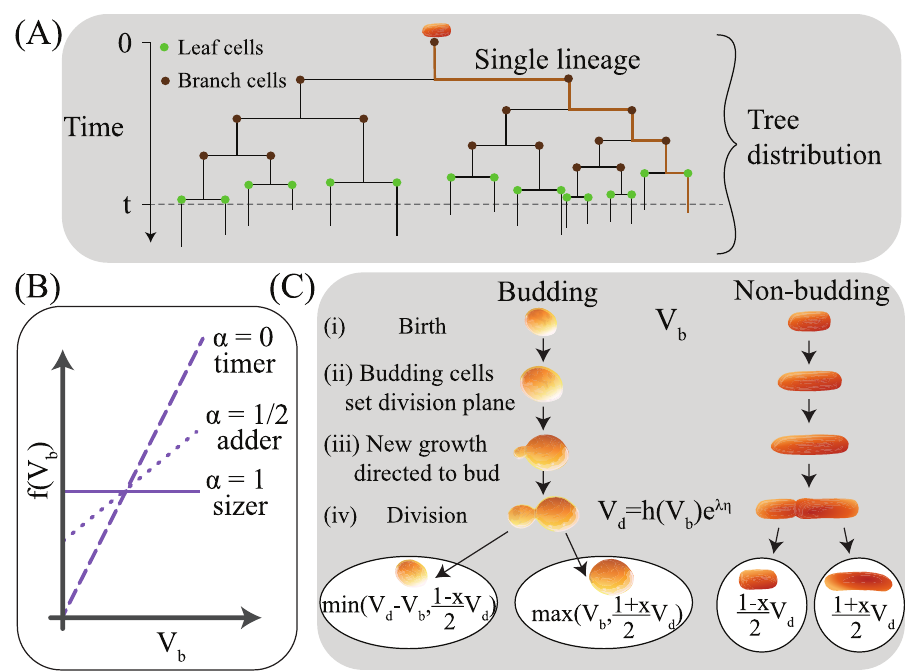
Fig 1. (A) Illustration of the tree distribution for a growing population of cells, terminated at a time-point t . We note that the tree distribution includes not just the generation times of “branch” cells whose cell cycles have finished at t , but also those “leaf” cells that are born before t but will complete their cell cycle after time t . A single lineage is shown in orange. Each node corresponds to a single cell division event. (B) Illustration of differences in cell size control policy. (C) Illustration of asymmetric division in different growth morphologies. Budding cells set the plane of division early on in the cell cycle and direct growth to a newly forming bud beyond that division plane. In contrast, non-budding cells set the plane of division when division occurs, meaning that growth throughout the cell cycle affects both progeny. The min and max conditions for budding cell size at birth are related to the observation that in a budding morphology, mother cells will only ever increase in size over subsequent cell cycles (see main text for details). In the expression for volume at division V d , η represents time-additive noise in the timing of cell